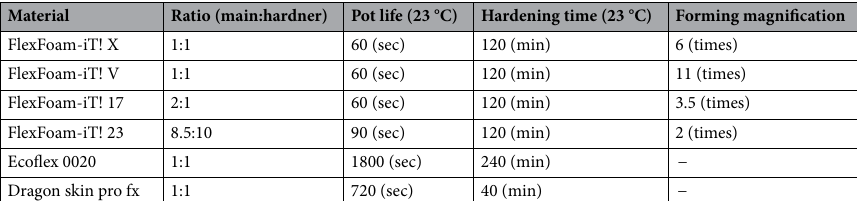
Table 1. Summary of the silicone materials used for the chest imaging phantom.